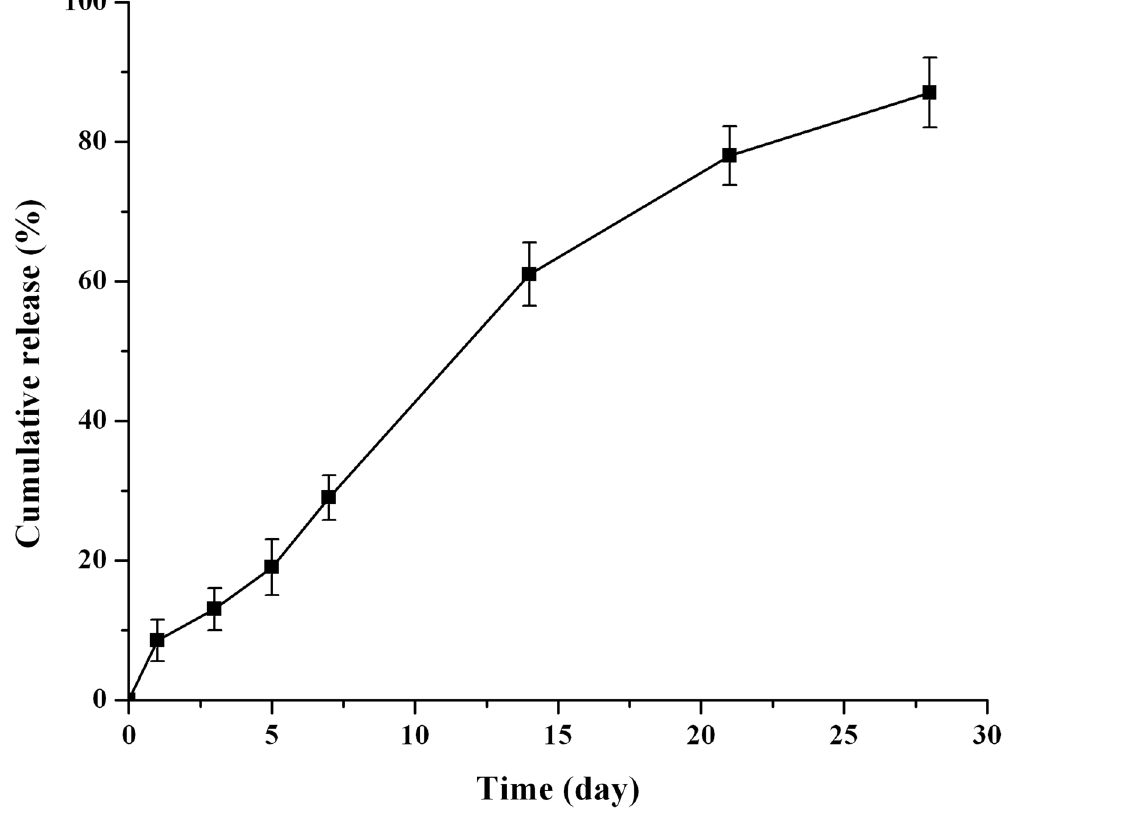
Fig 3. In vitro release profile of nalmefene loaded microspheres. In 0.1 M PBS (pH 7.4) at 37°C (n = 6).